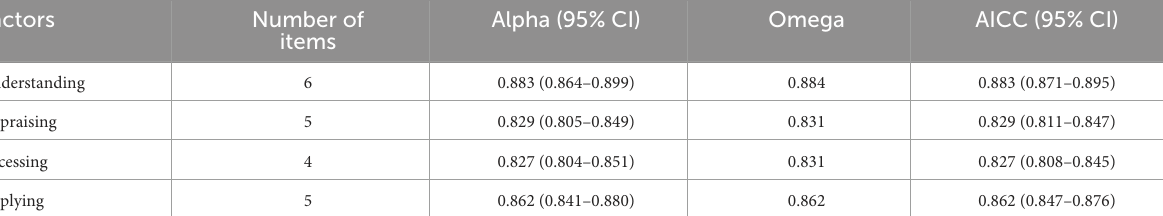
TABLE 4 The reliability of the Persian version of HLS-COVID-Q22 ( n = 880). Factors